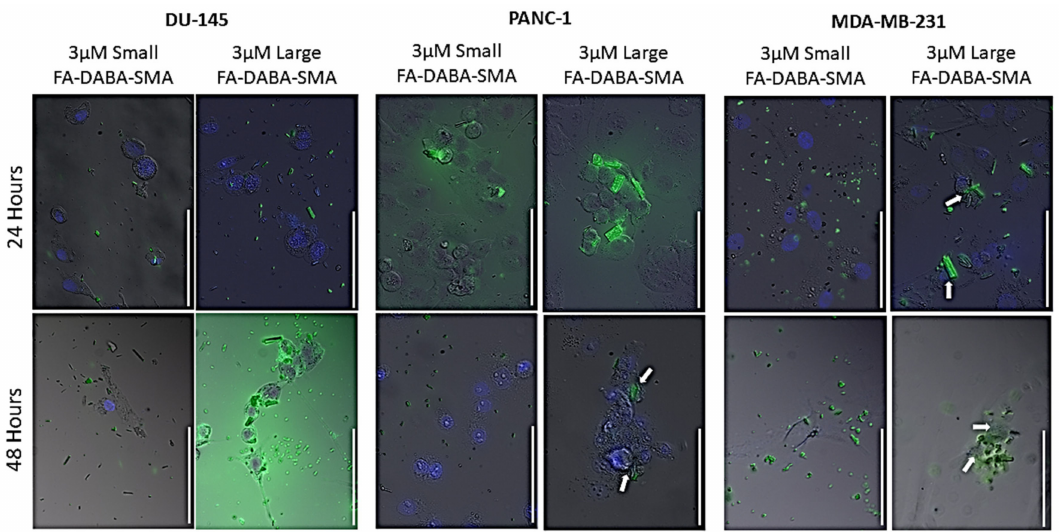
Figure 3. Live-cell fluorescence microscopy of curcumin-loaded FA-DABA-SMA binding FR mediating endocytosis and preferentially targeting the nucleus. Live cell tracking of the large (350 kDa) and small (20 kDa) curcumin loaded FA-DABA-SMA on DU-145, PANC1, and MDA MB-231 cells over 24 and 48 hours. Pictures were taken at 400 × magnification. Blue DAPI stain represents the nuclei, and green fluorescence is the curcumin loaded nanopolymers. Results are a combination of two independent experiments with similar results. Arrows indicate